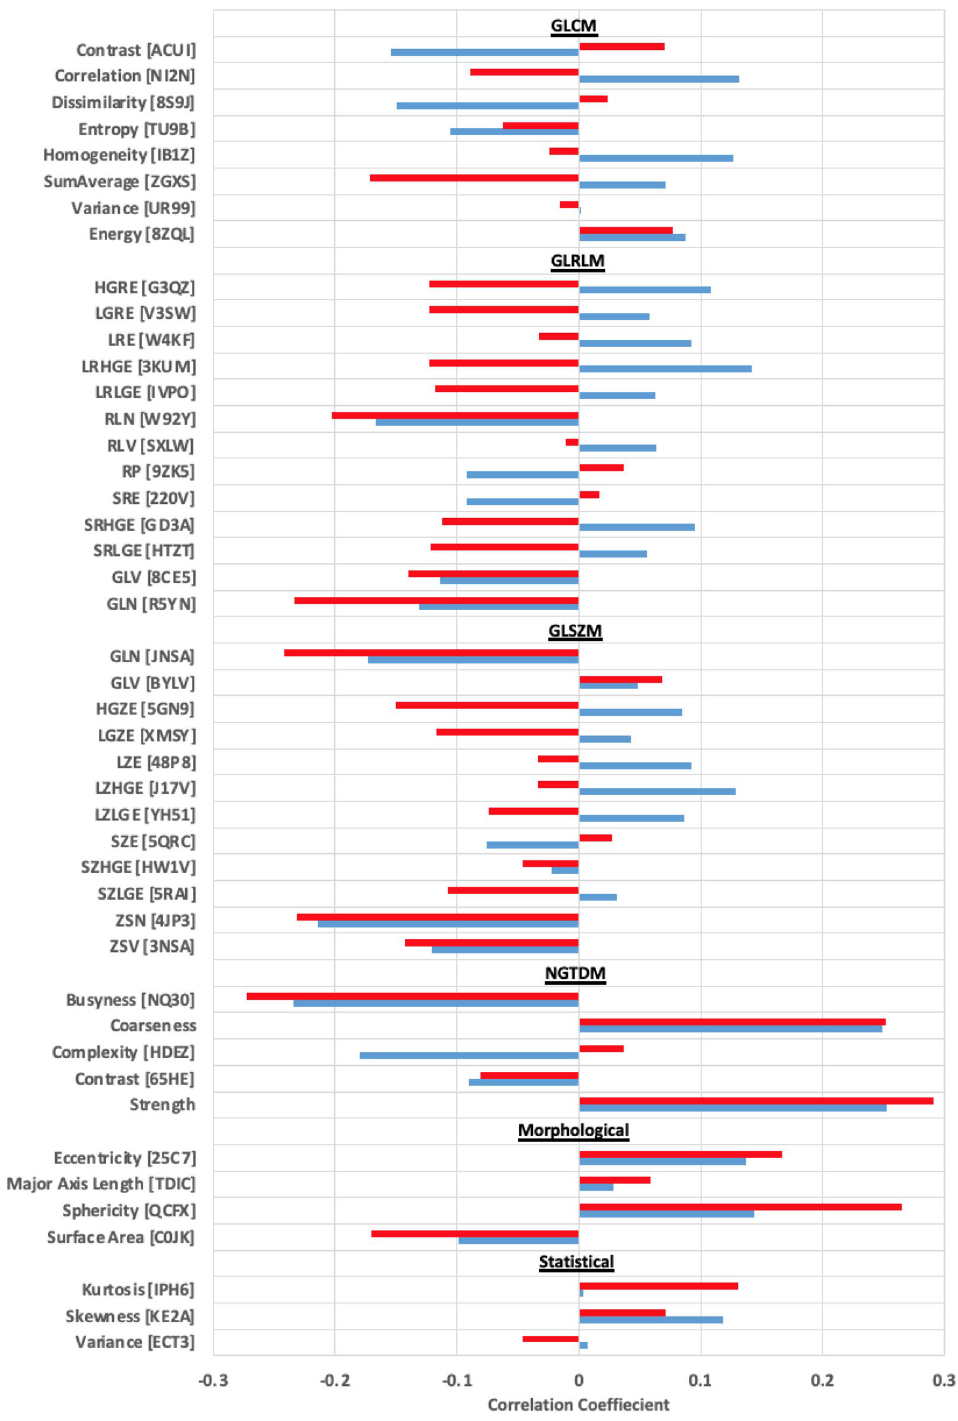
Figure 3. Spearman’s rank correlation coefficient between the mean absolute percent difference in radiomic feature derived data (%∆RF) between auto and manual contours plotted against Dice similarity coefficient (DSC), stratified by class. This was done for two populations, all fractions (blue) and for fractions with ΔVol > |10%|